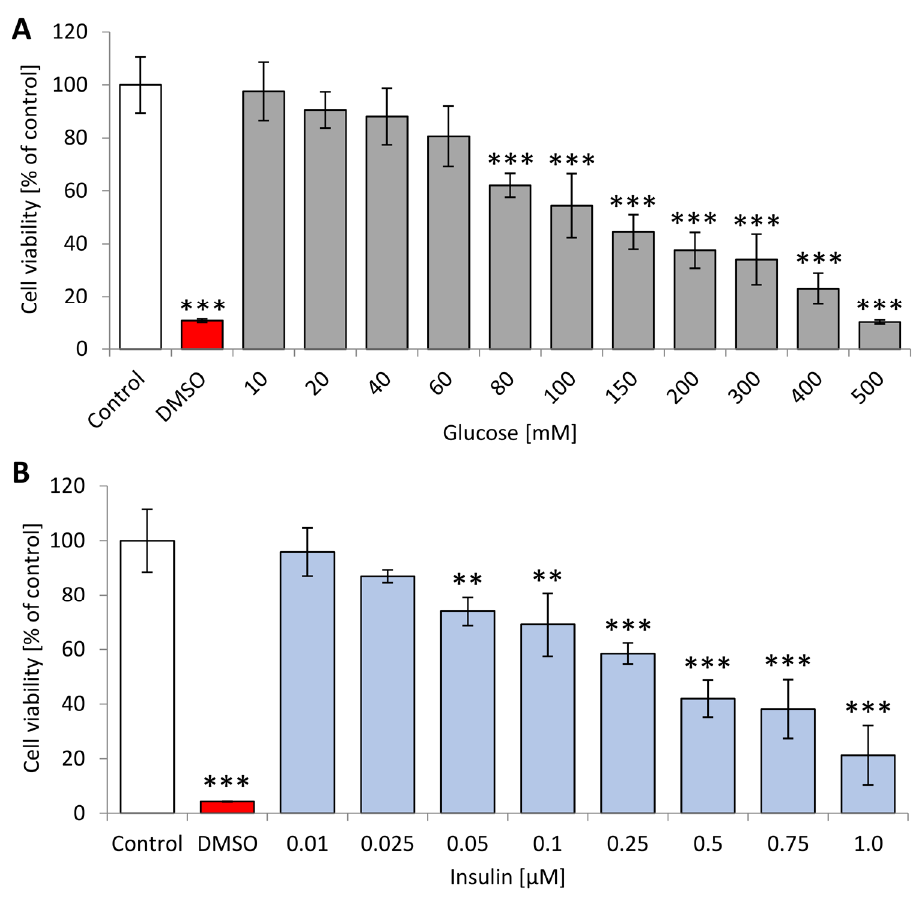
Figure 1. Metabolic activity measured in MTT assay of neuron-like cells after 24 h incubation with different concentrations of ( A ) glucose and ( B ) insulin. Control—untreated neuron-like cells; DMSO—PC12 cells treated with DMSO. Statistically significant differences compared to the untreated neuron-like cells: ** p < 0.01, *** p < 0.001.